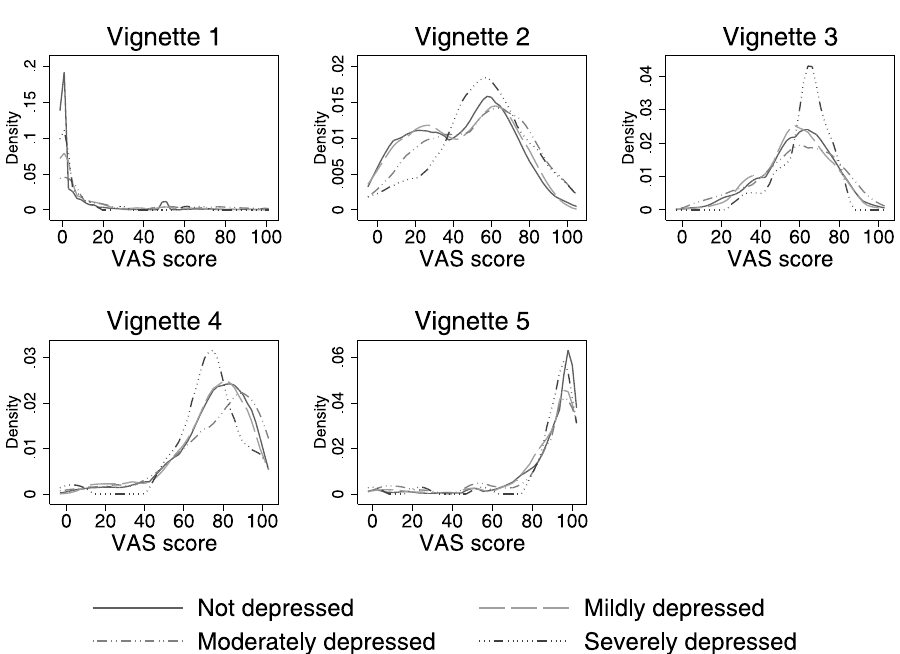
Fig 4. Distribution of vignette evaluations by depressive symptoms. Note : 0 means ‘no difficulty’ and 100 means ‘extreme difficulty’ with sleep.